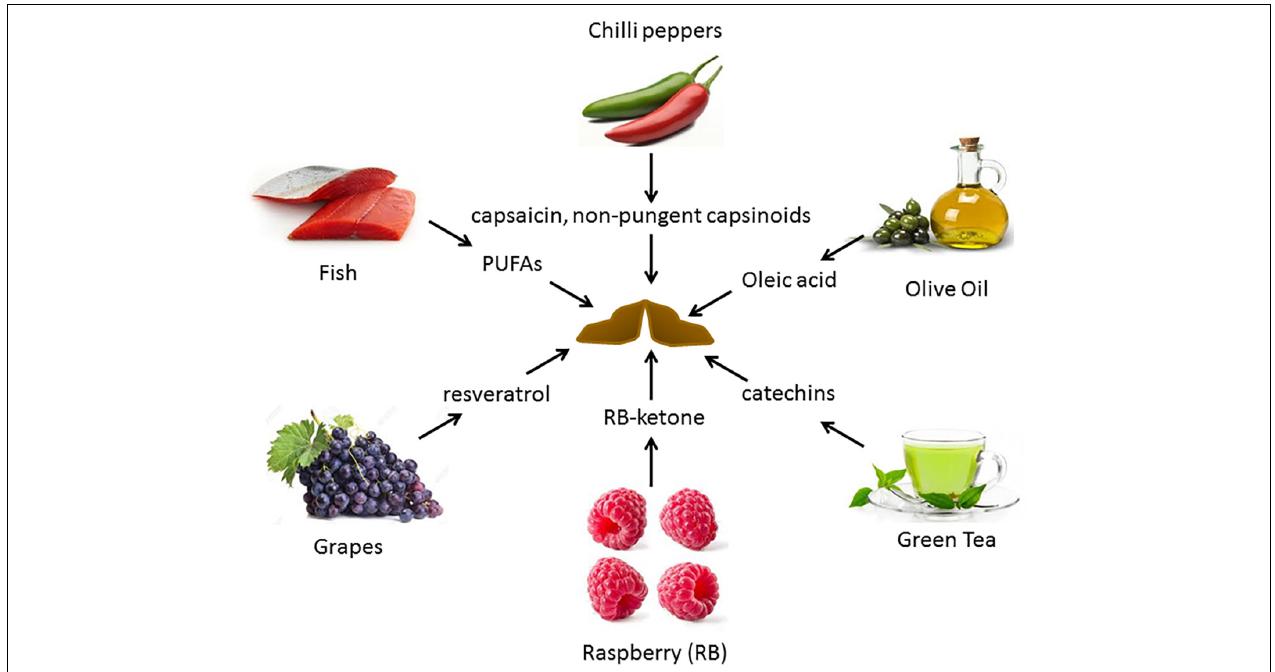
FIGURE 2 | Food-derived molecules shown to be involved in BAT activation and browning, and their sources. Several diet-derived molecules have been shown to activate brown fat and browning. These are obtained from both plant and animal products.